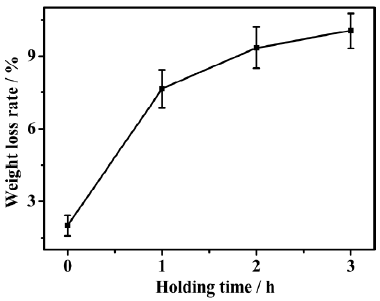
Figure 2. Weight loss rate of the sintered MM Fe-Mn-Si samples as a function of the isothermal holding time.